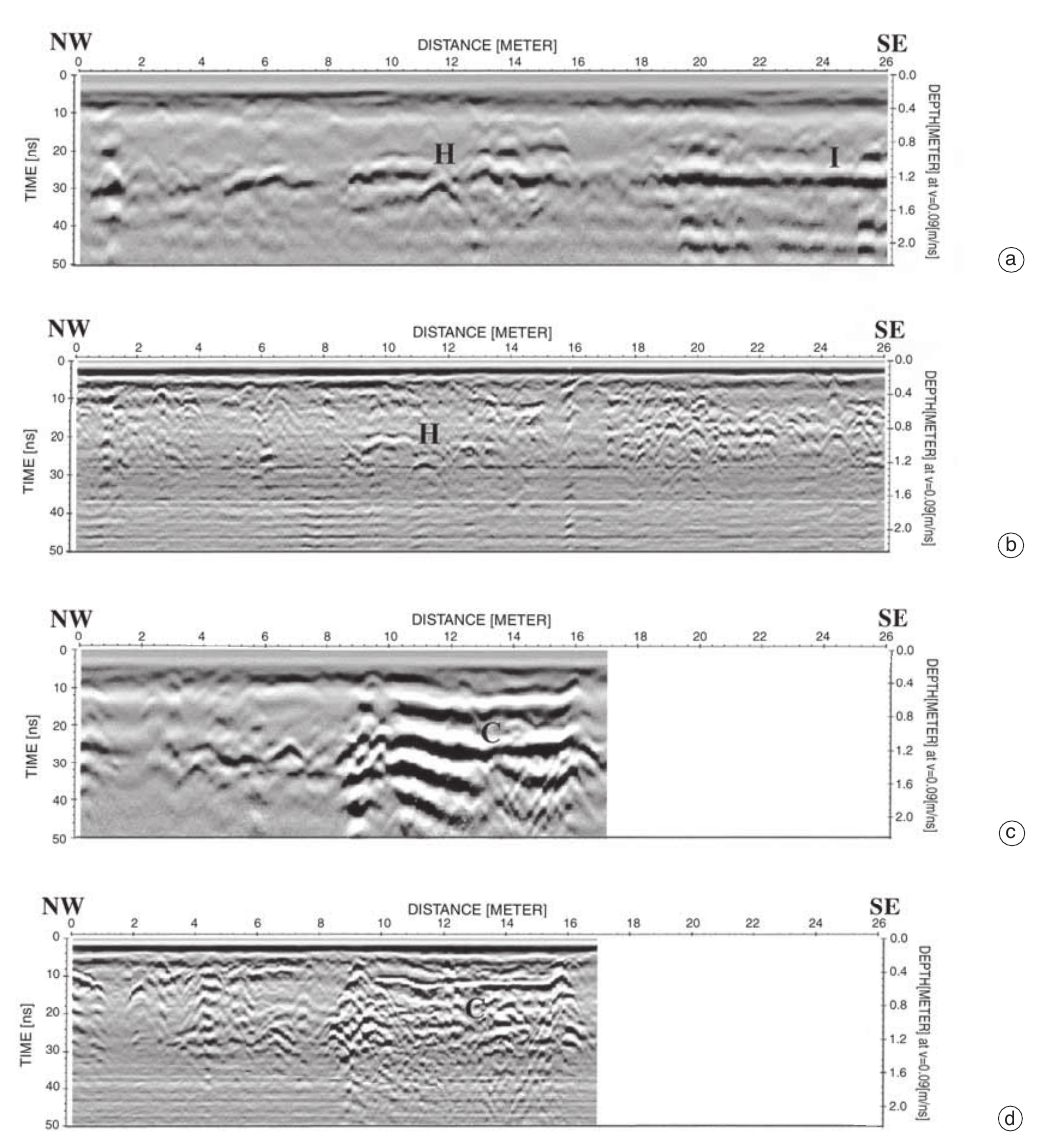
Fig. 3a-d. Examples of radar sections from profiles relative to the southern part of the site: Profile L2, 200 MHz (a) and 500 MHz (b); Profile L1, 200 MHz (c) and 500 MHz (d). I denotes the soil-bedrock reflection; H a hyperbolic diffraction probably due to a ditch in the bedrock; C a strong anomaly probably due to an old refilled